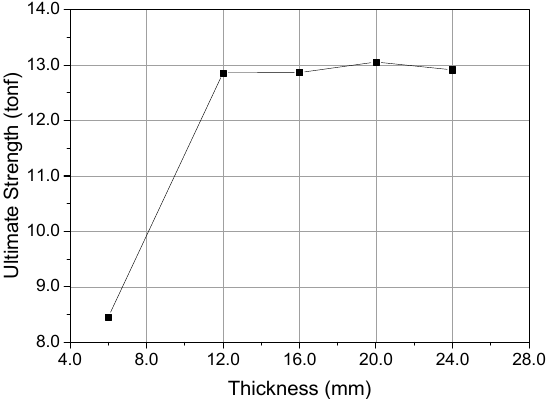
Figure 12. Ultimate strength of the deck structure as a function of the carling thickness.